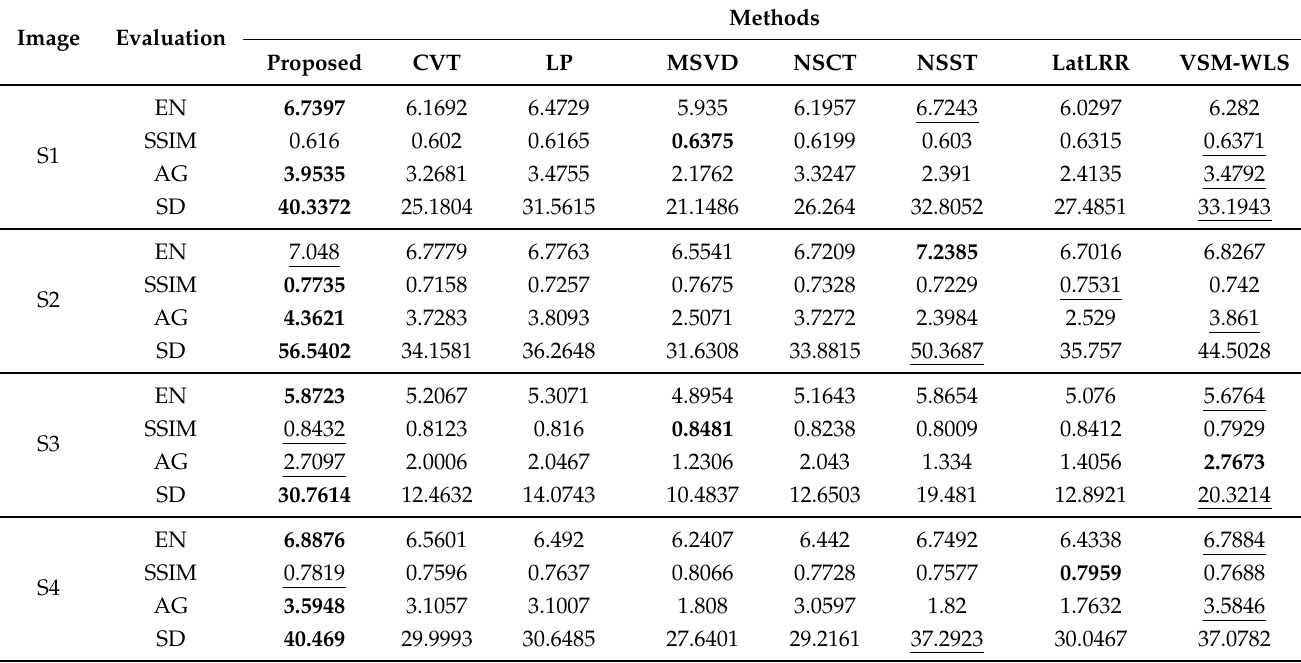
Table 1. Objective evaluation results of different fusion